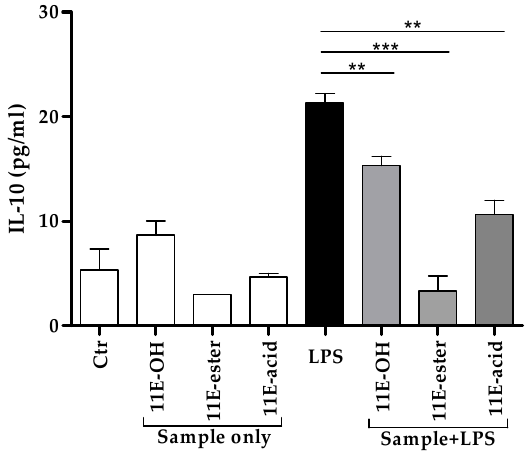
Figure 6. Effect of eicosenoid compounds on the production of IL-10 by phorbol 12-myristate 13-acetate (PMA)-differentiated THP-1 cells in the absence and presence of LPS (0.5 µg/mL). The IL-10 levels were significantly decreased in all three combination treatments when compared with positive control LPS ( n = 3). Ctr: Untreated control; LPS: Lipopolysaccharide; (11E-OH): (Z)-11-eicosenol; (11E-ester): Eicosenoate; (11E-acid): Eicosenoic acid; **: Significant ( p < 0.01); ***: Significant ( p < 0.001).